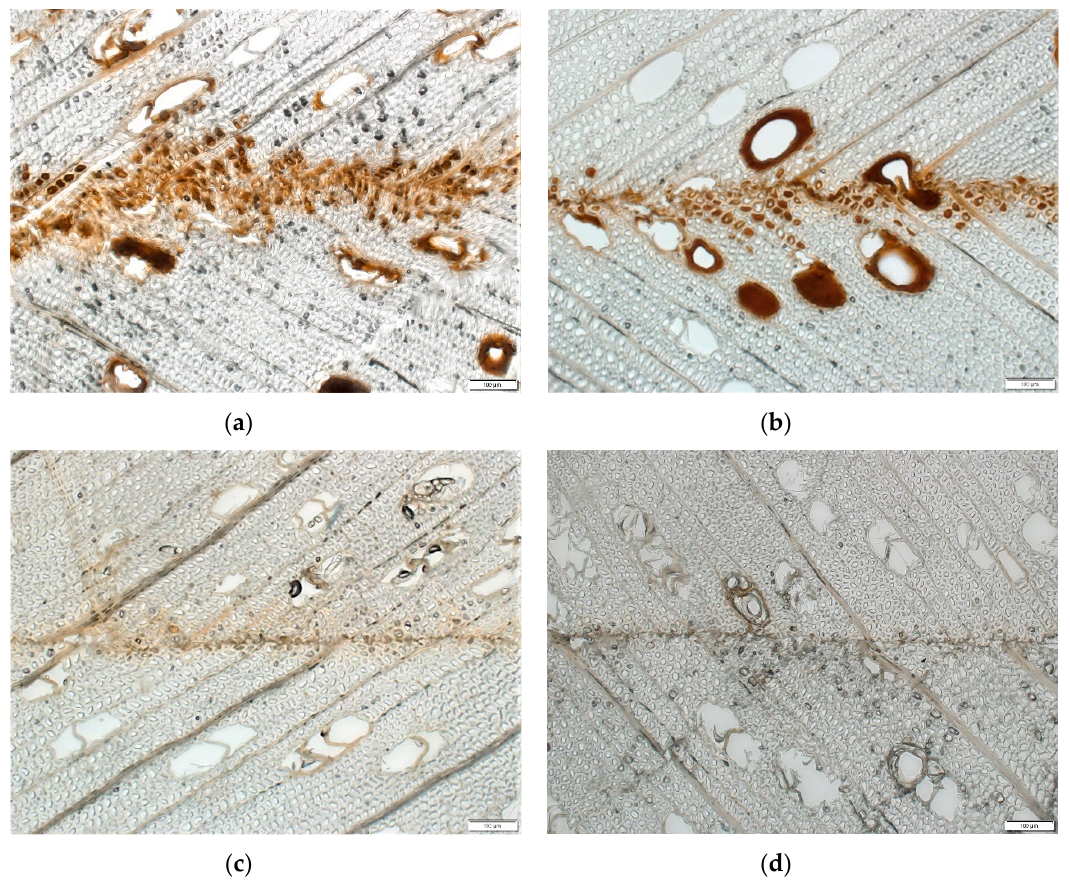
Figure 4. Transverse visible-light view of horizontal bondlines in 2-layered veneer samples: ( a ) ALS- Transverse visible-light view of horizontal bondlines in 2-layered veneer FOH, ( b ) ALS-FOH +m, ( c ) ALS-pMDI, and ( d ) ALS-pMDI + m.